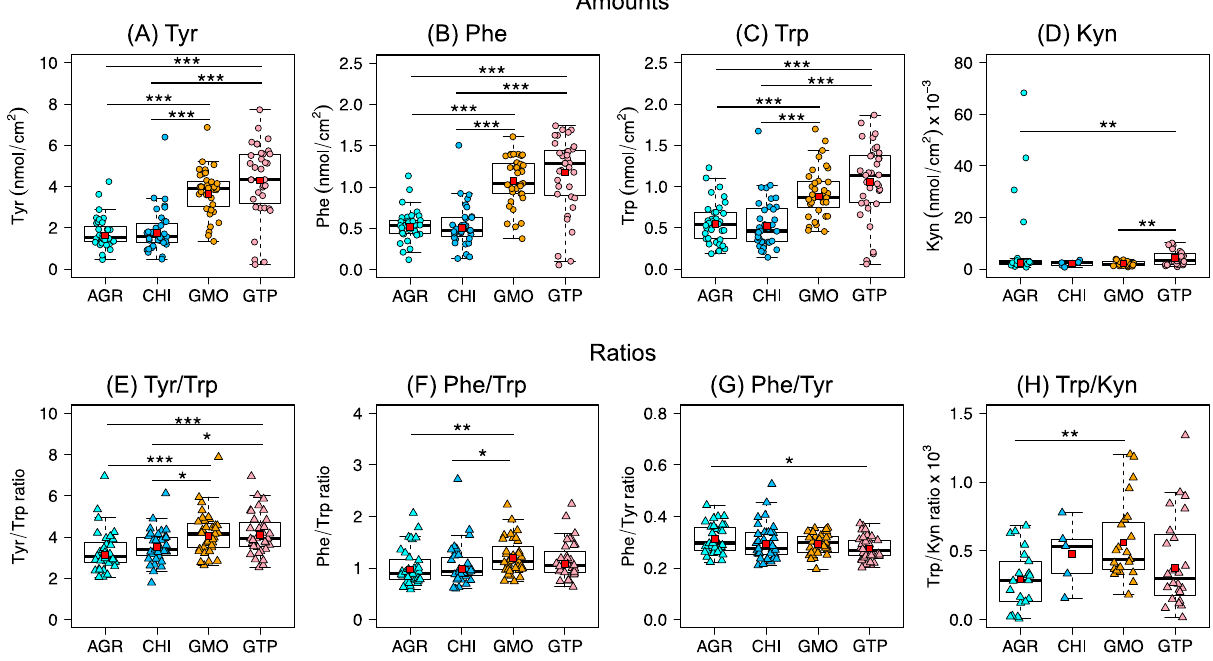
Figure 3. Comparison of the capacity of AGR, CHI, GMO, and GTP to collect Tyr ( A ), Phe ( B ), Trp ( C ), and Kyn ( D ) from the skin surface of healthy volunteers. Ratios between collected amounts of Tyr/Trp ( E ), Phe/Trp ( F ), Phe/Tyr ( G ), and Trp/Kyn ( H ). The significance levels used were: * p < 0.05, ** p < 0.01, *** p < 0.001. See Table S7 for a compilation of p -values derived from a statistical analysis